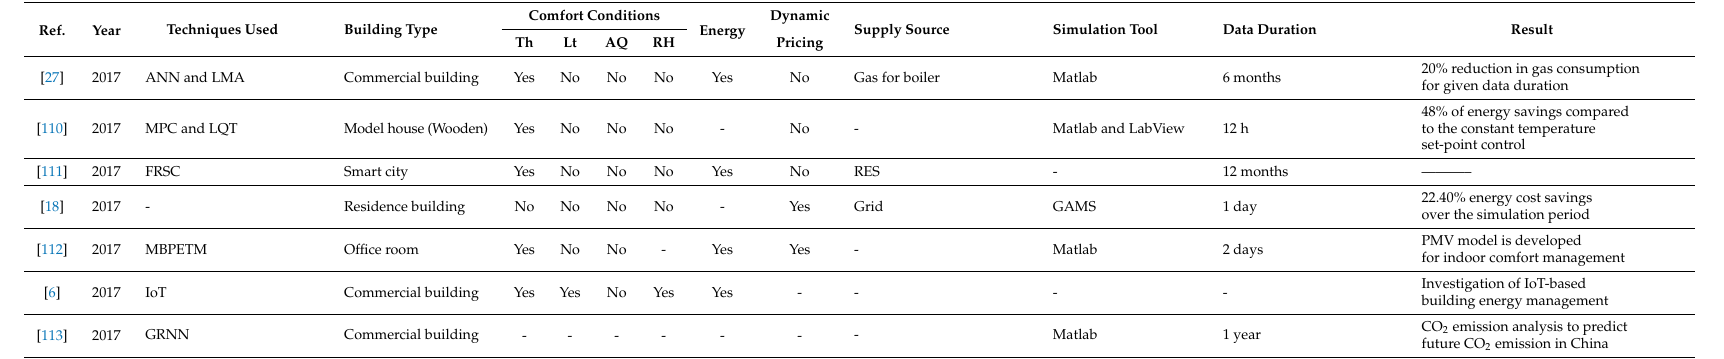
Th—Thermal, Lt—Lighting, AQ—Air Quality and RH—Relative